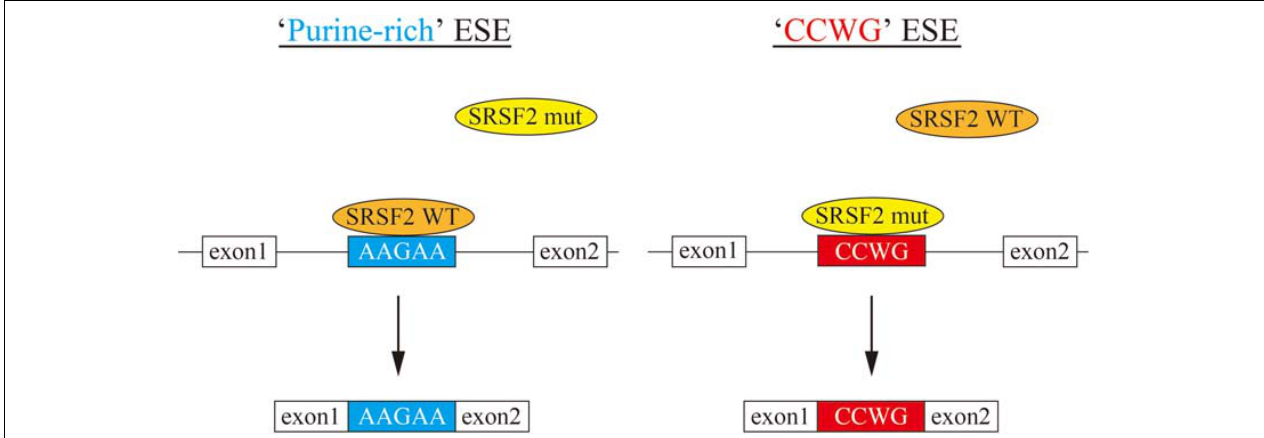
FIGURE 4 | A model for splicing changes caused by SRSF2 mutations in the patients. (Left) SRSF2 wild-type protein binds to purine-rich exonic splicing enhancer for promotion of exon recognition. (Right) SRSF2 mutants, SRSF2 P95H and P95R, preferentially bind to CCWG motif-containing exons to promote aberrant